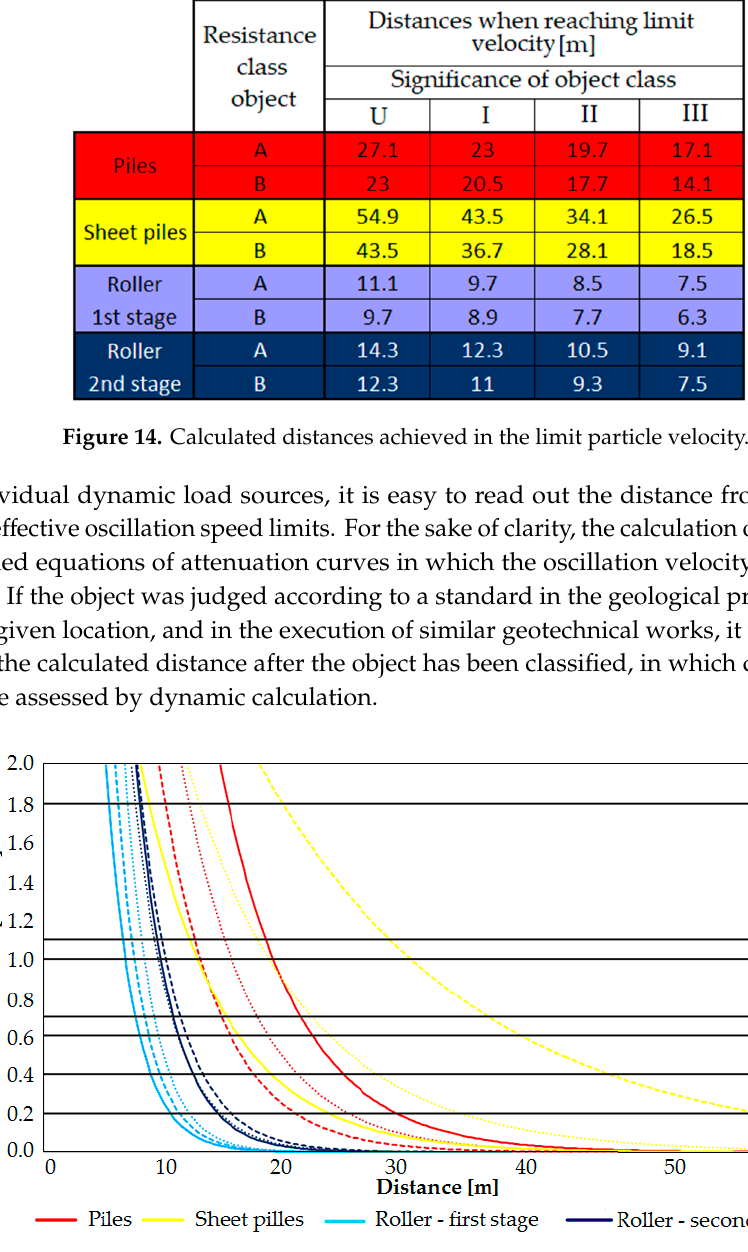
Figure 15. Attenuation curves for the given environment acquired pursuant to in situ measurements.